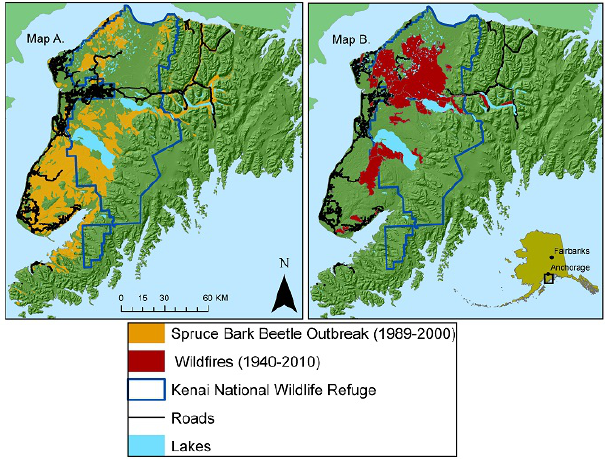
Fig. 2 . Maps of the Kenai Peninsula Alaska, including the Kenai National Wildlife Refuge. Map A depicts spruce bark beetle ( Dendroctonus rufipennis ) outbreak perimeters from 1989-2000. Map B depicts wildfire perimeters from 1940-2010.